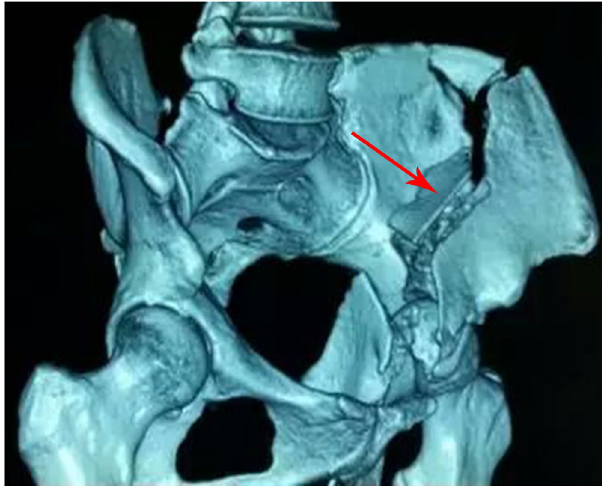
Figure 3. Minor fragment called the “key stone” was indicated by red